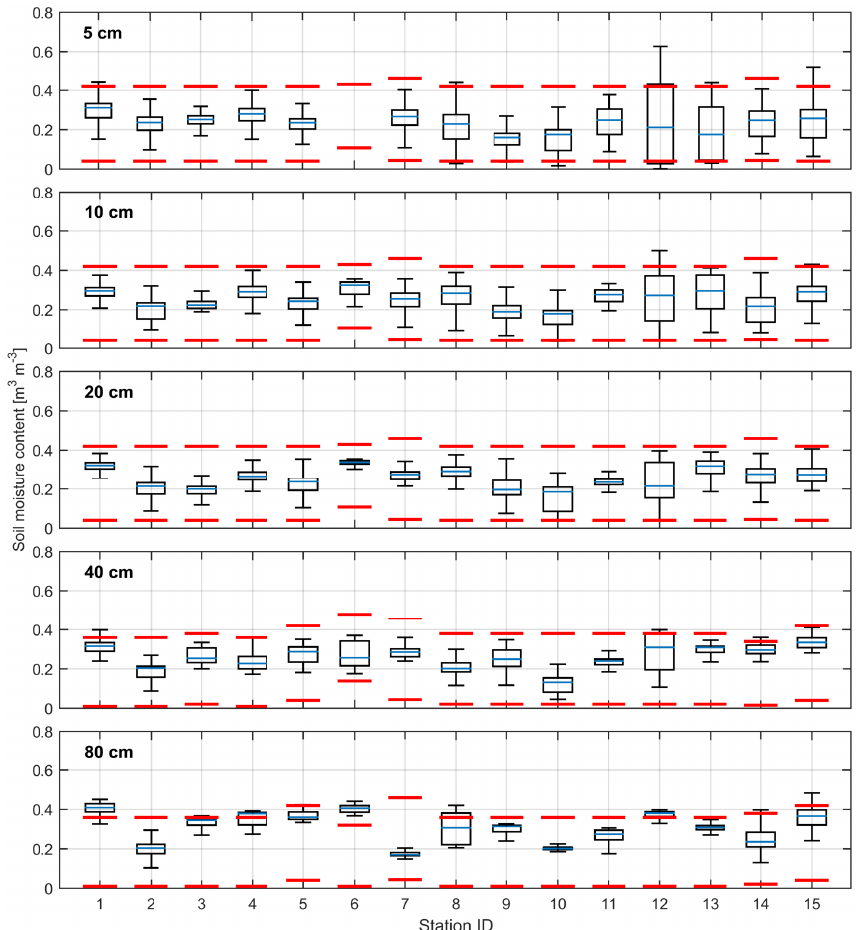
Figure 8. Box plots of the soil moisture measurements with theoretical wilting point and saturated soil moisture content from BOFEK2012 (red lines), for each depth measured (5 April 2016–4 April 2017). Note that the box plot of 5cm depth of station 6 is not shown: these data are removed from the data set because of sensor